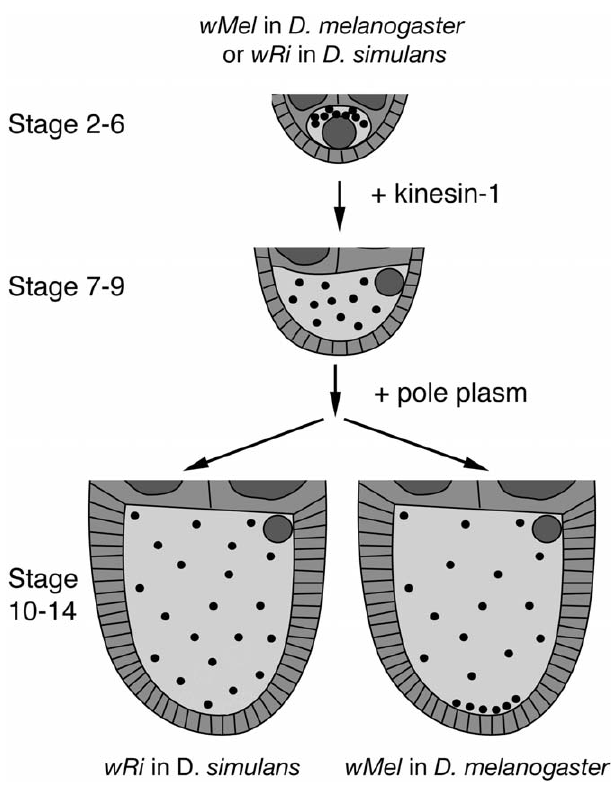
Figure 4. Model for Strain-Specific Wolbachia Localization Strategies wMel and wRi Wolbachia localize to the oocyte anterior from stages 3 to 6. Kinesin-1 transports Wolbachia away from the oocyte anterior during stages 7–9, carrying bacteria throughout the oocyte and toward the posterior pole. wRi remains evenly distributed into late oogenesis. In contrast, wMel Wolbachia near the posterior cortex interact with pole plasm to facilitate posterior wMel